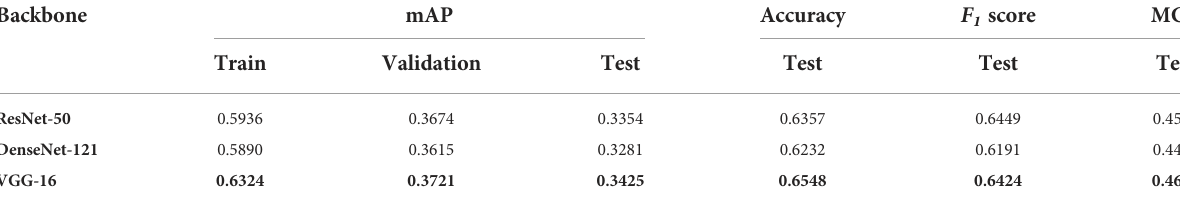
TABLE 4 Object detection mAP values for Train, validation and test sets for three different model backbones.